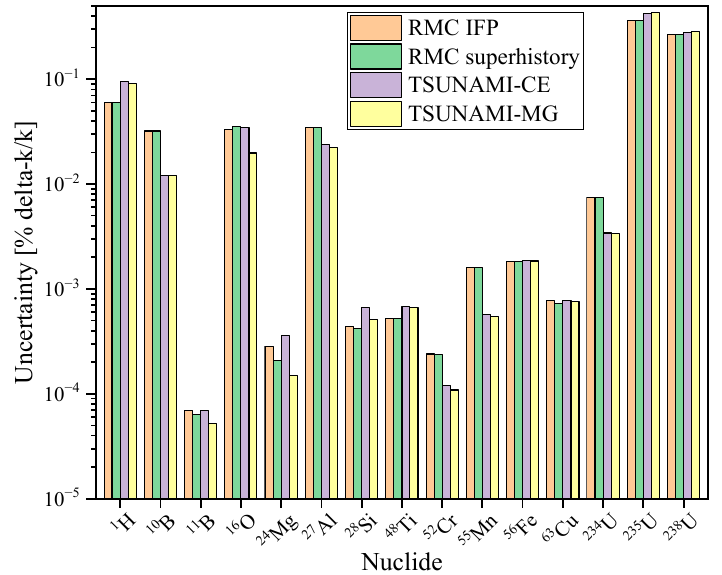
Figure 5. Uncertainty in k eff caused by uncertainty of nuclear data of different nuclides (SCALE 56-group-cov7.1 covariance library).